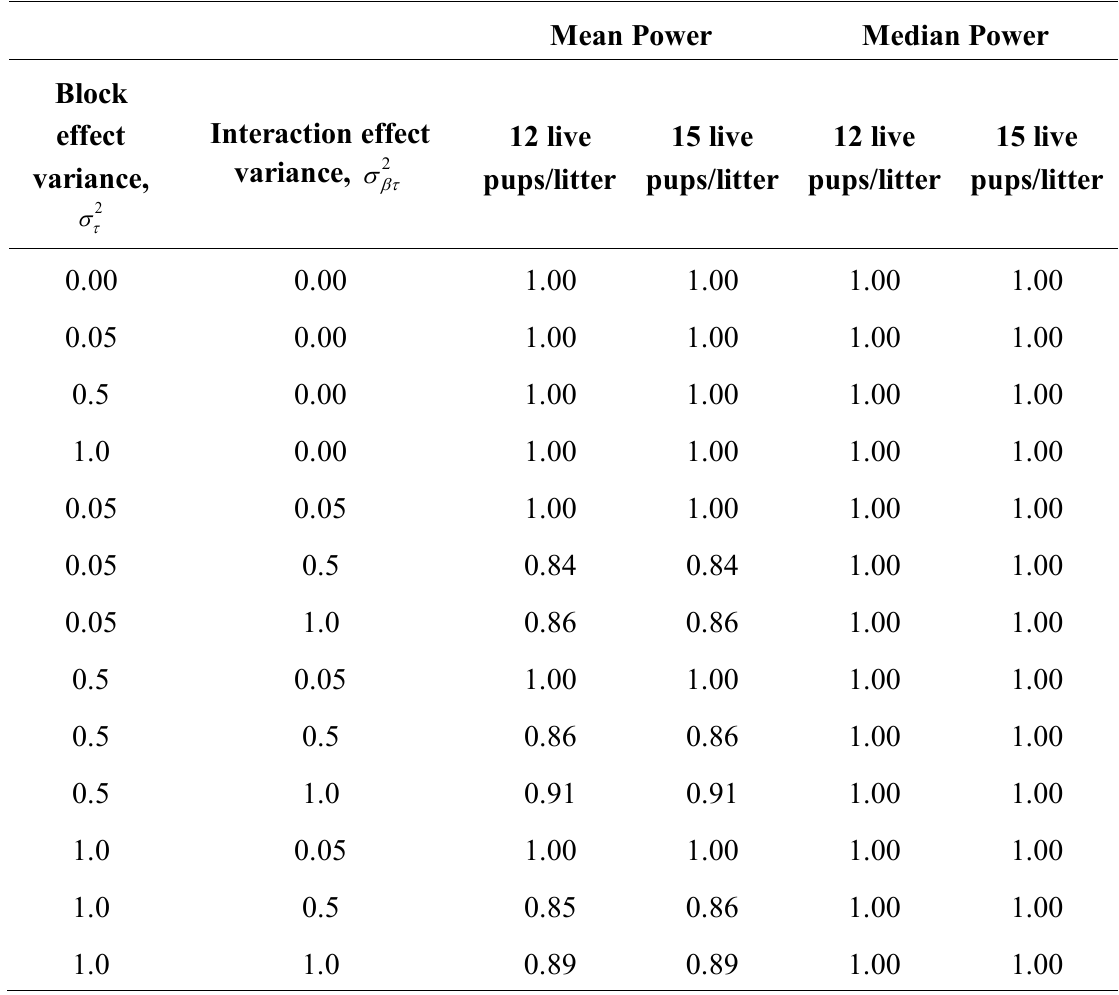
Table 2. Power to detect a 0.6 g difference in average pup weight using a linear model: Two-block